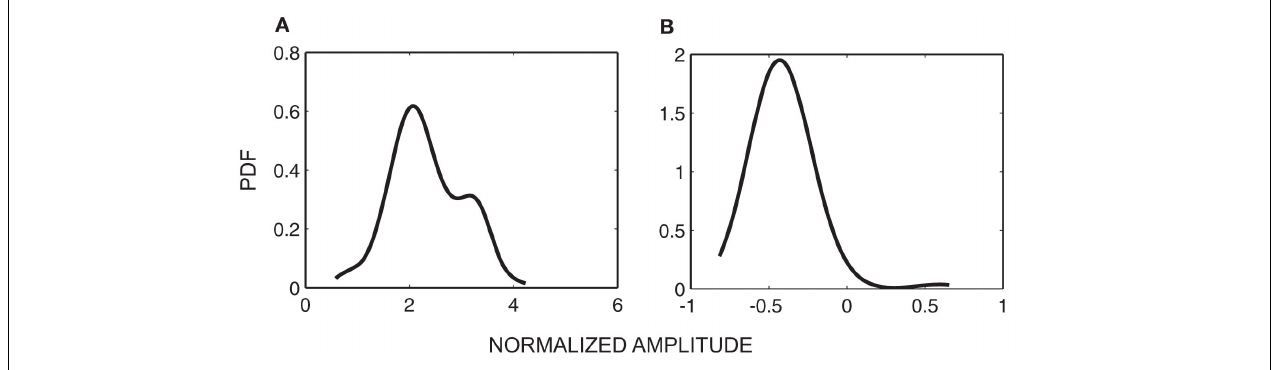
FIGURE 6 | (A) Probabilistic density function (PDF) of Y t − 1 given S t − 1 = extension and S t = flexion ; (B) Probabilistic density function of Y t − 1 given S t − 1 = flexion and S t = extension